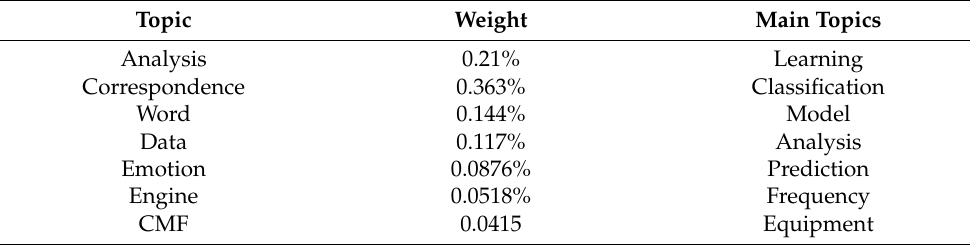
Table 1. Result of weight analysis among LDA Topics.